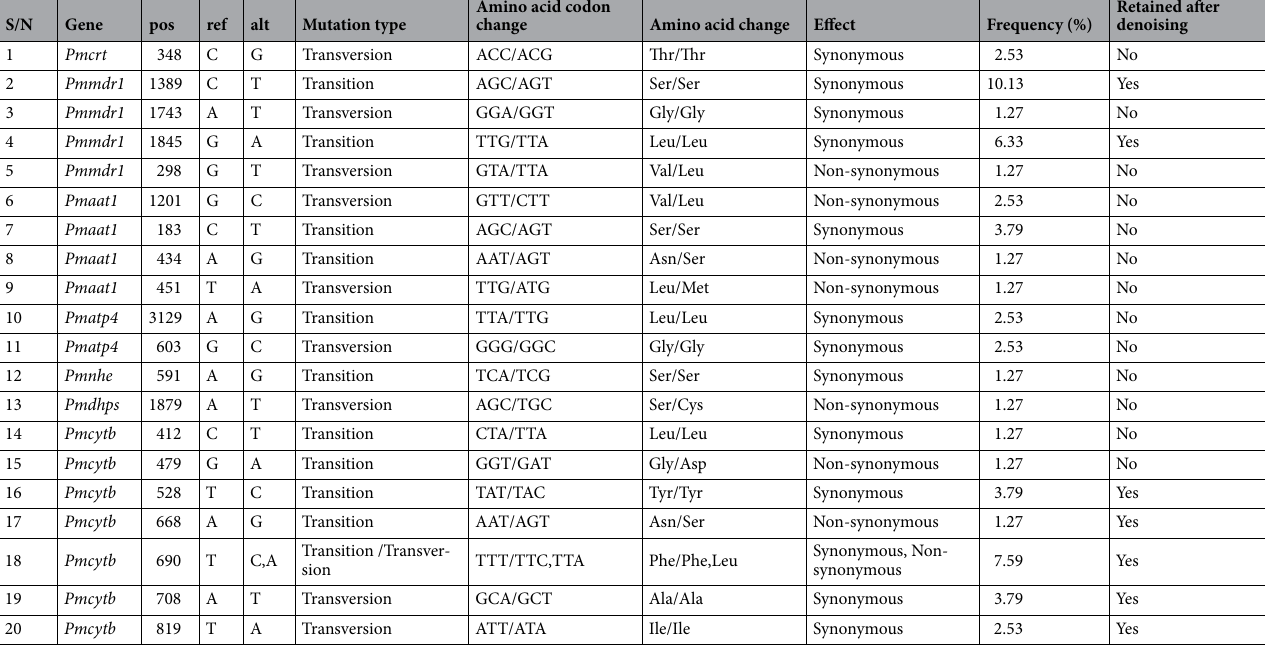
Table 6. Single nucleotide polymorphisms (SNPs) detected in orthologous P. malariae drug resistance